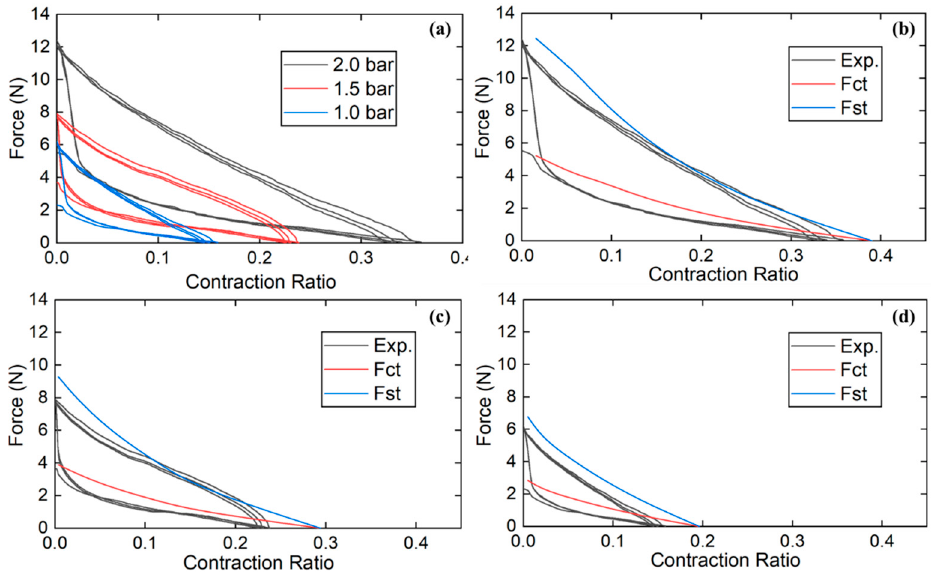
Figure 7. ( a ) Output characteristics of HPAM at three pressures, ( b ) comparison between data of model and experiment at 2.0 bar, ( c ) comparison between data of model and experiment at 1.5 bar, ( d ) comparison between data of model and experiment at 1.0 bar.